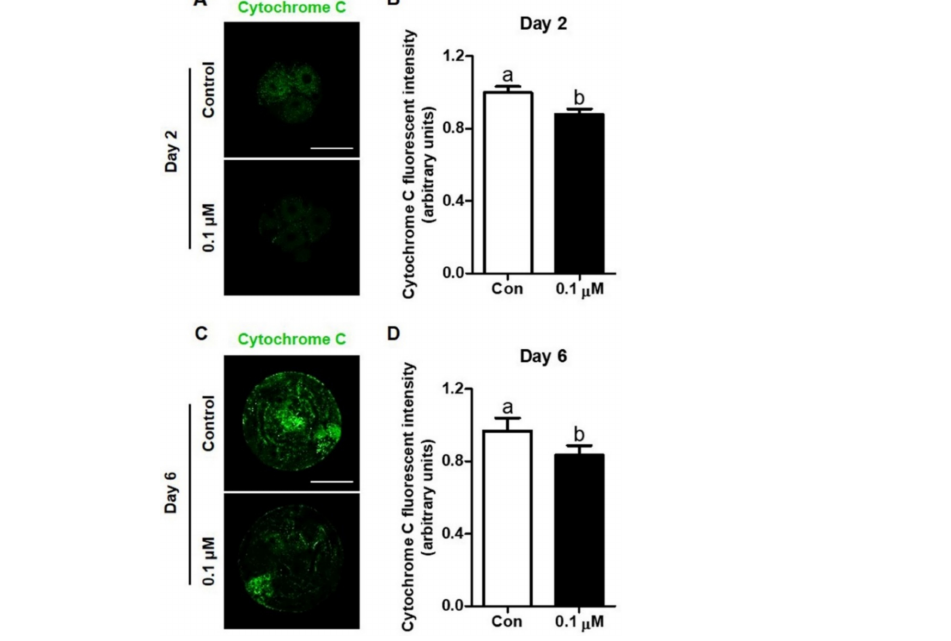
Figure 5. Effect of lycopene on the expression of cytochrome c in porcine IVF embryos. ( A , C ) Representative images of Day-2 embryos and Day-6 blastocysts of the indicated groups stained with an antibody directed against cytochrome c and ( B , D ) comparison of expression in Day-2 embryos and Day-6 blastocysts in the indicated groups. Different superscript letters (a,b) represent the significant difference ( p < 0.05). Bar = 100 µ M. Abbreviations: IVF, in vitro fertilized; Con, control; 0.1 µ M, 0.1 µ M lycopene.